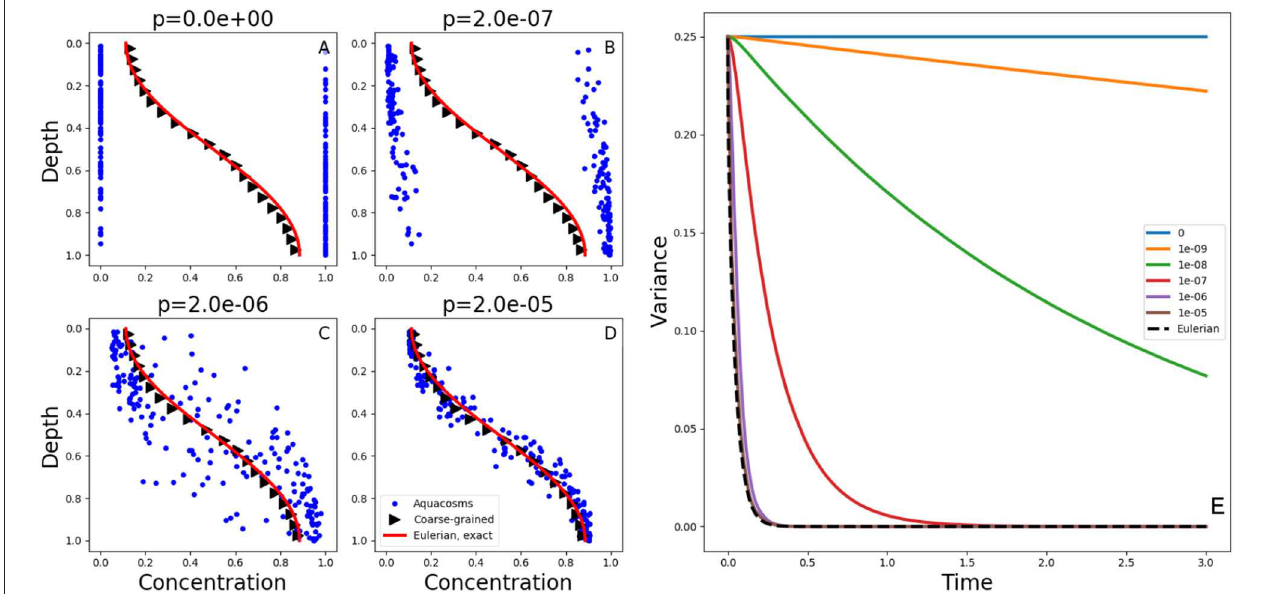
FIGURE 2 | (A–D) Exact solutions at time t = 0.05 of the diffusion Equation (1) with the initial condition (2) and no-flux boundary conditions (red lines). The blue dots show the position and the concentration of the aquacosm simulations with the same diffusivity and varying coupling strength p . The black triangles are a coarse-grained version of the same data, obtained with a Gaussian kernel estimator with standard deviation 0.1 (see section 2). (E) variance, as a function of time, in Lagrangian aquacosm simulations with varying coupling strength p (solid lines) and variance of the exact solution of the Eulerian problem (1) (dashed